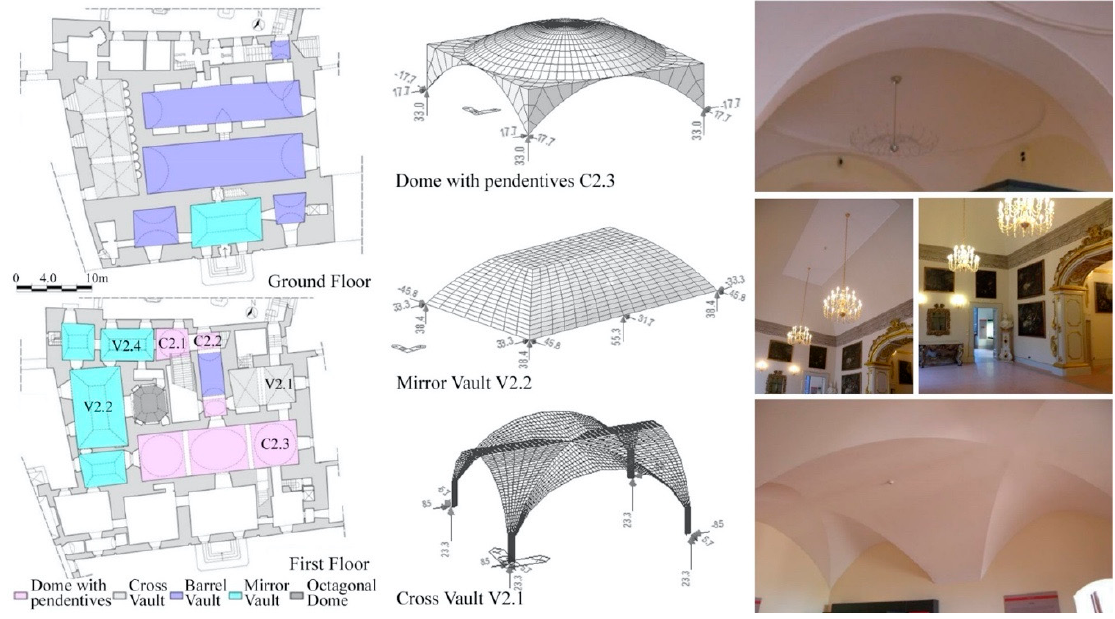
Figure 16. Two-dimensional finite element model of a vault typology performed with the software MIDAS Gen [43].